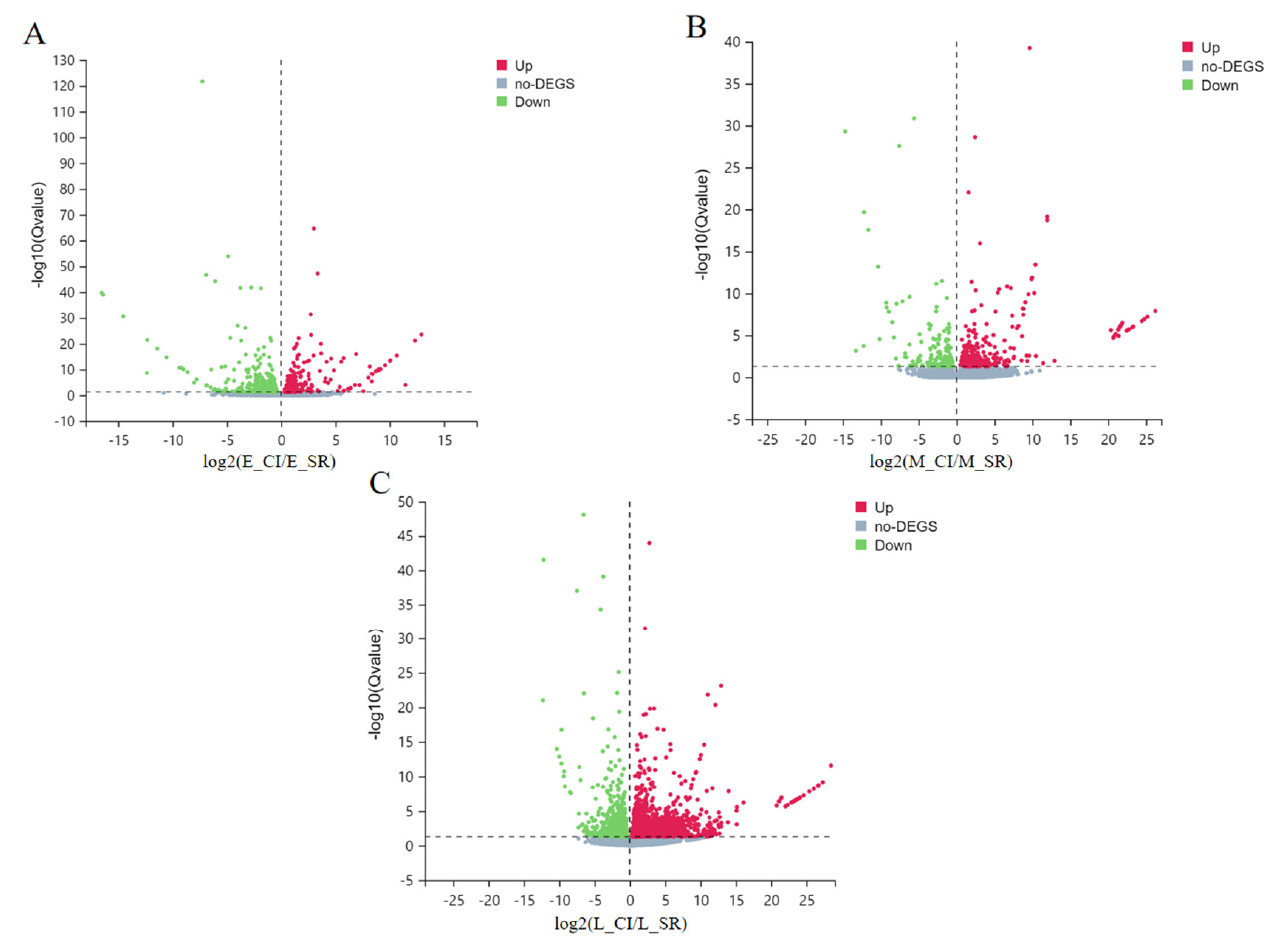
Figure 3. DEG volcano map. ( A ) E116-vs.-E115 volcano map. ( B ) M116-vs.-M115 volcano map. ( C ) L116-vs.-L115 volcano map. Red dots represent up-regulated genes, green dots represent down- regulated genes, and gray dots represent non-DEGs. The X-axis represents the fold change of the difference after conversion to log2 values, while the Y-axis represents the significance value after conversion to − log10 values.